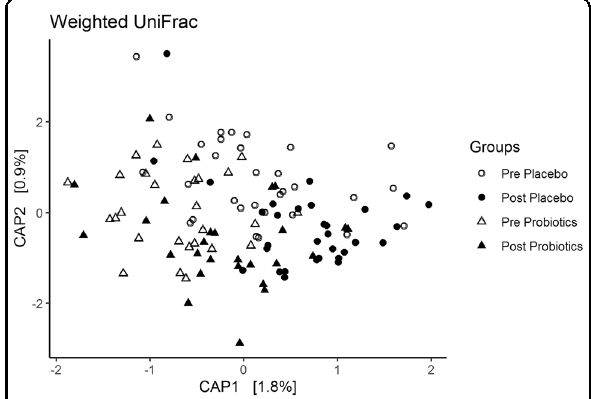
Fig. 3 Beta diversity. Weighted Unifrac dissimilarity matrix plotted using Canonical Analysis of Principal Coordinates (CAP) ordination for all groups and